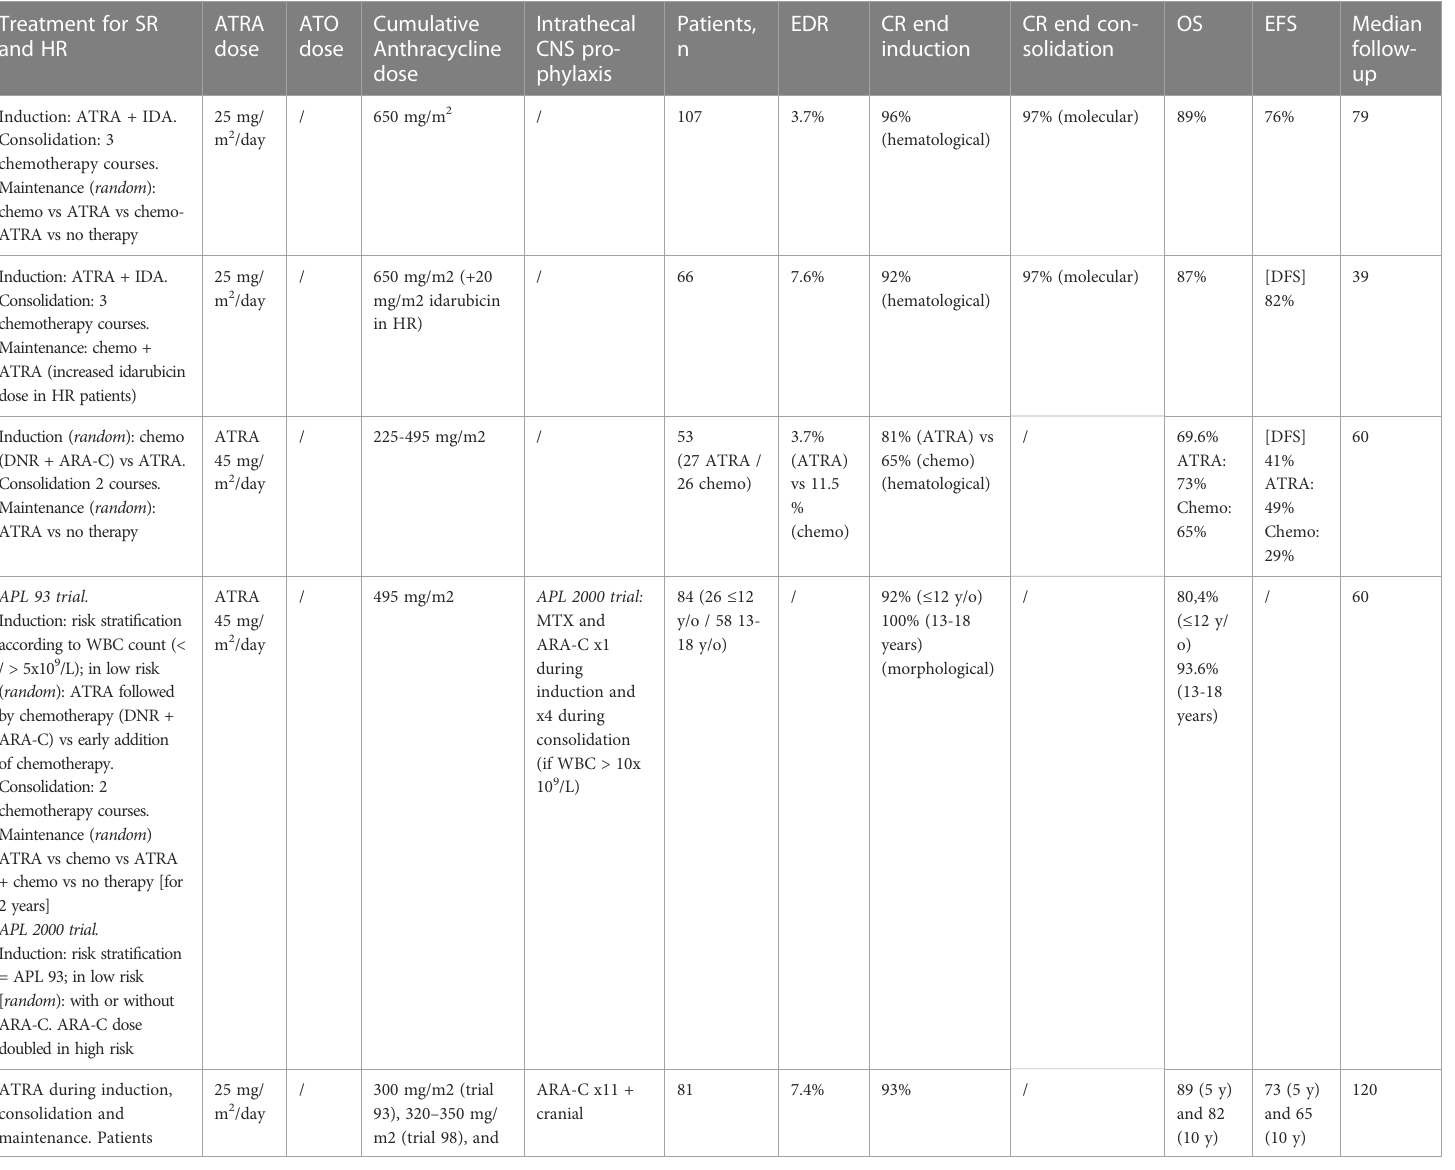
TABLE 1 Summary of pediatric studies using ATRA/ATO combination.